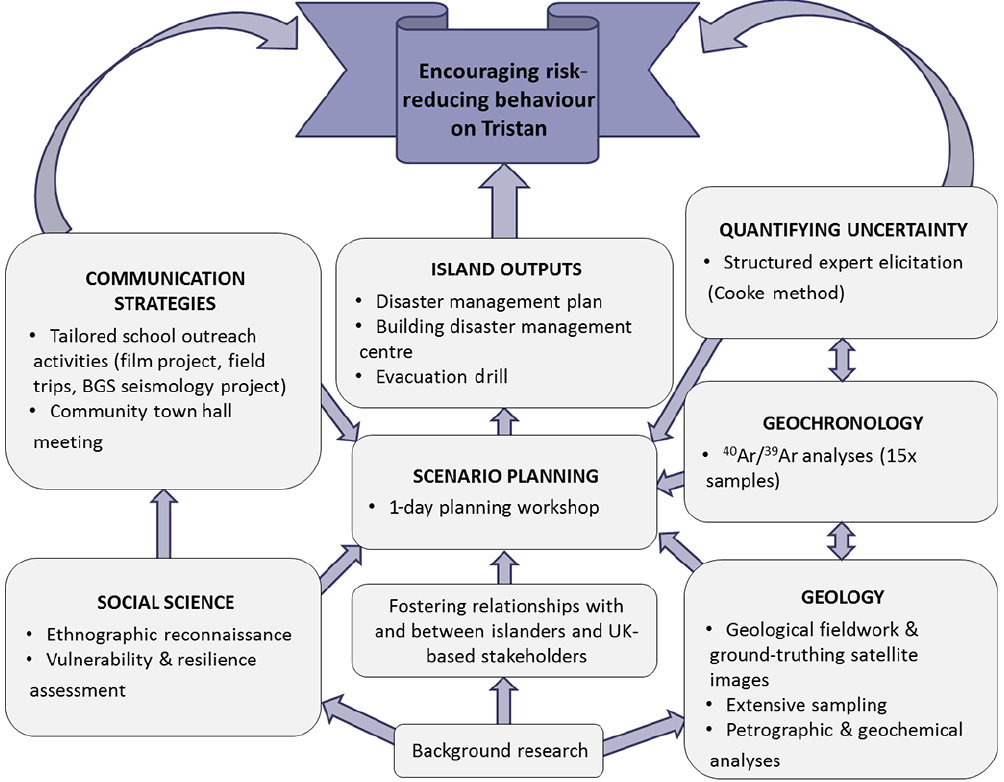
Figure 2. Schematic of interdisciplinary research components. The data-gathering phase involved collecting geological, geochronological, probabilistic and social information. These data then informed the action research phase, manifest as a scenario planning